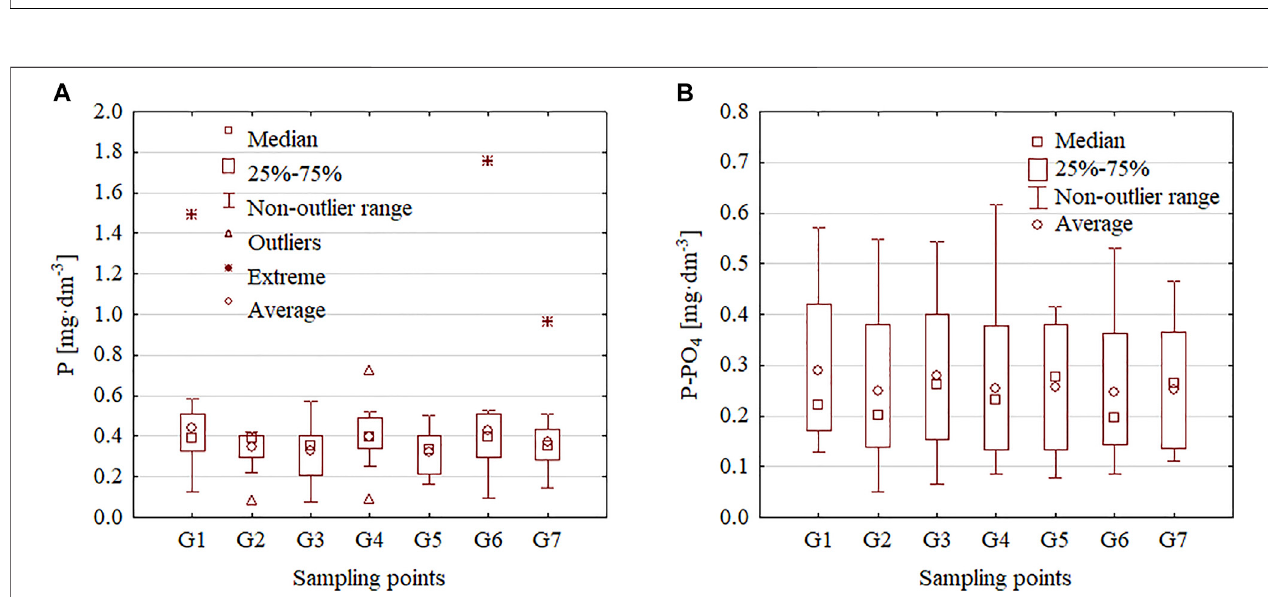
FIGURE 5 | Spatial variability of the content of (A) orthophosphate phosphorous; (B) total phosphorus in the waters of the G ł uszynka river during the hydrological years 2016 – 2018.